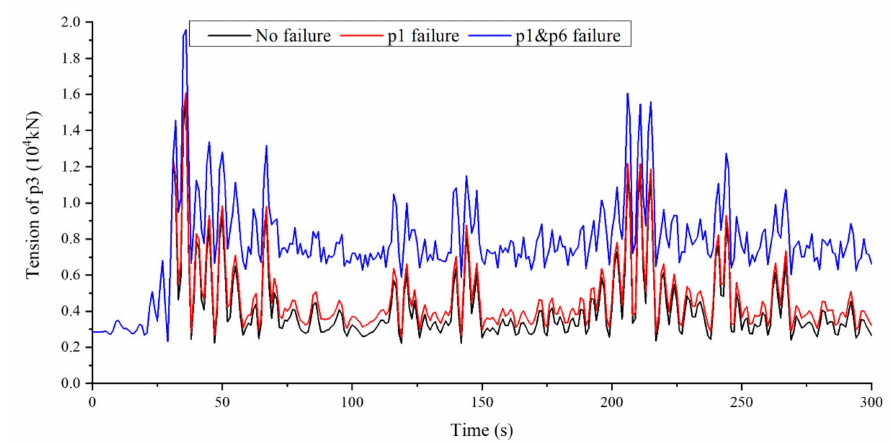
Figure 13. p2 tension time–history curve.